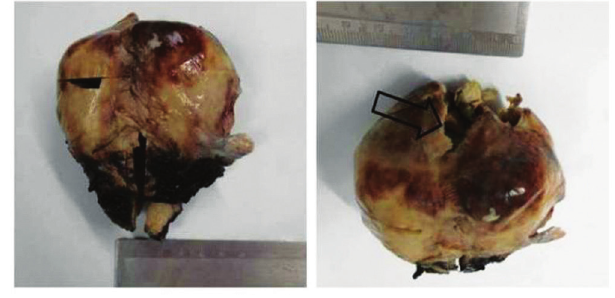
figurE 2 − The resected uterus. The arrow points the possible perforation site